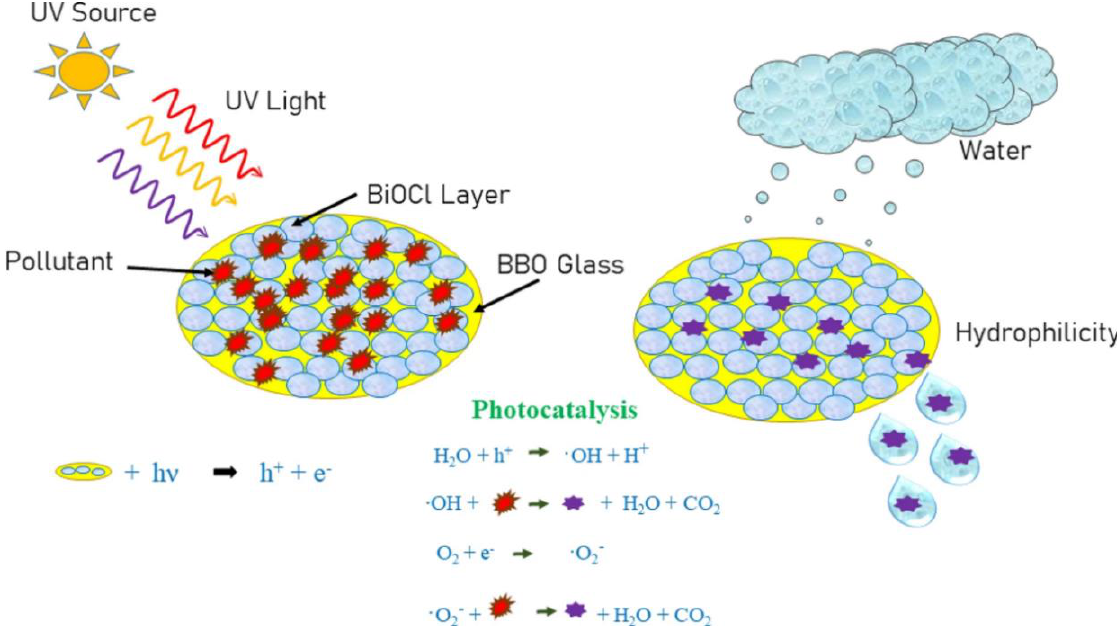
Figure 13. SEM images of ( a – i ) BBO HCl etching samples, ( j ) BBO as-quenched samples and ( k ) a typical cross-sectional image of the BBO HCl 3. ( l ) Surface roughness and images of BBO glass sam- ples. Reprinted with permission from Ref. [113].